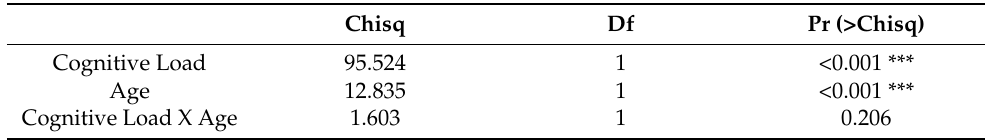
Figure 5. The ACPT score as a function of Age and Cognitive Load (ACPT-A: Low Load, ACPT-AX: High Load). Bands represent 95% confidence intervals. Table 4. Analysis of deviance with the type II Wald chi-square tests for ACPT score as a function of load and age. (*** = p -value < 0.001).